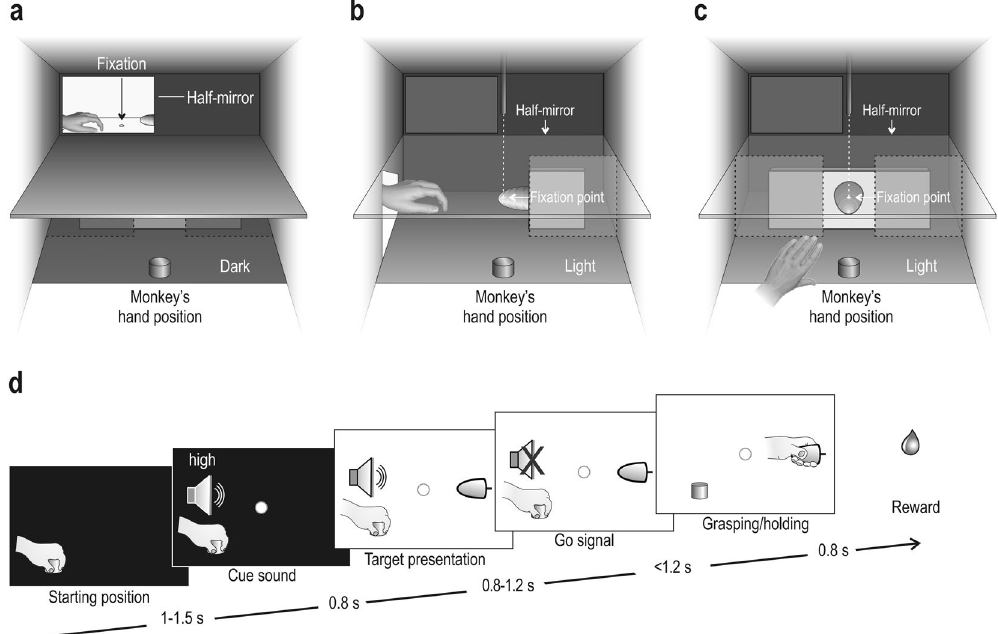
Figure 1. Apparatus, experimental conditions, and phases of the task. (a–c) Box and apparatus for presenting the monkey with experimenter’s action in three different combinations of viewpoint and spatial location: lateral view in the (a) extrapersonal space, and (b) peripersonal space, and (c) subjective view in the peripersonal space. (d) Task phases are the same for all